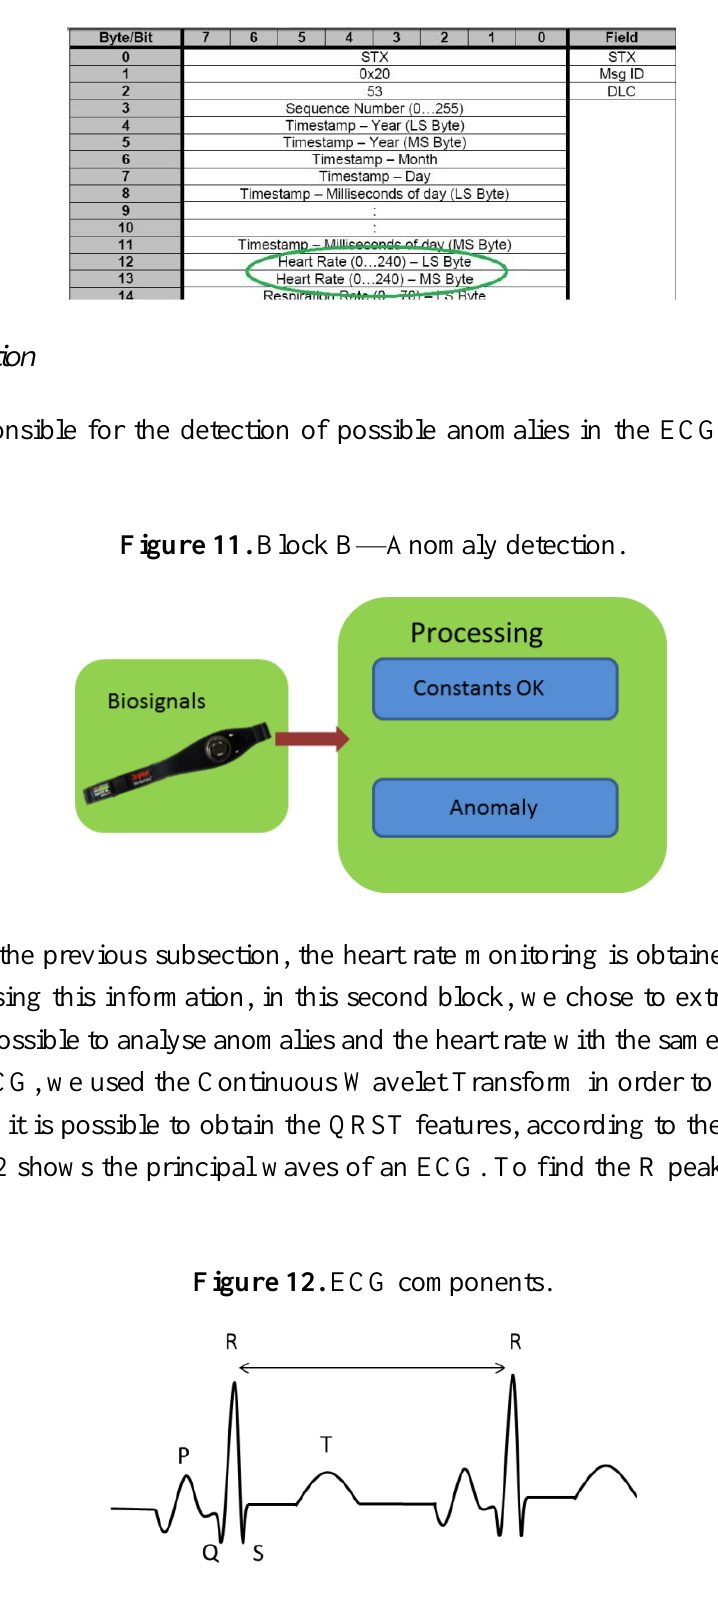
Figure 10. General Data Packet.